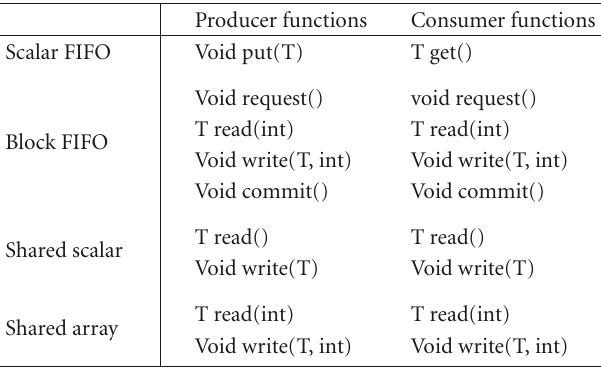
Table 1: Interface functions for the communication channels in- serted by